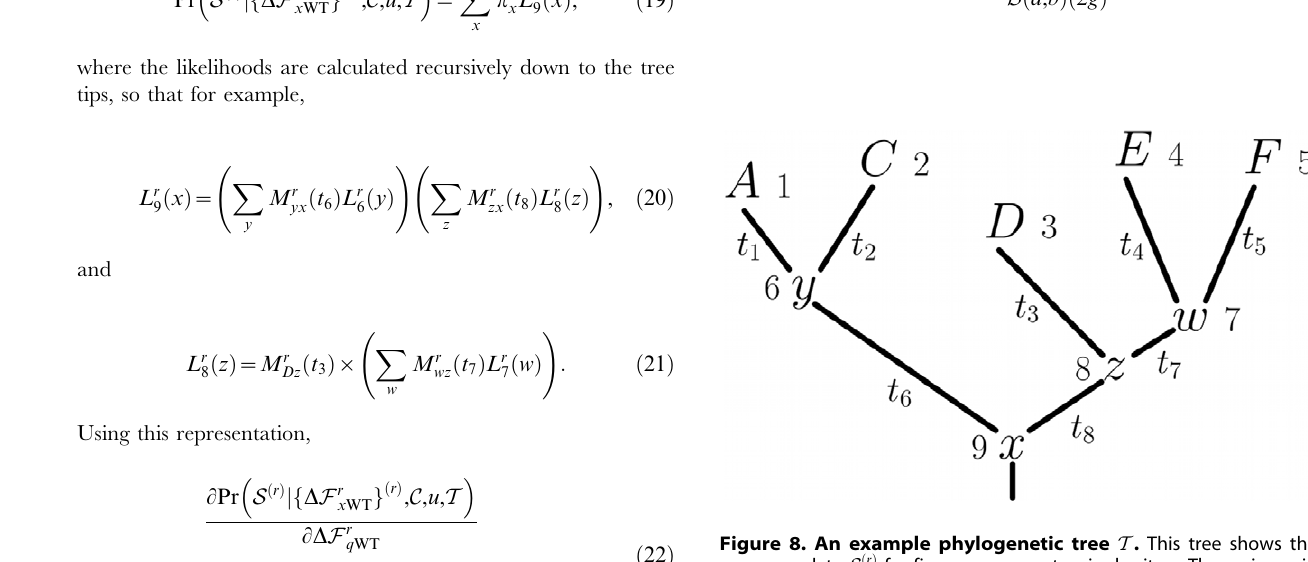
Figure 8. An example phylogenetic tree T . This tree shows the sequence data S r ð Þ for five sequences at a single site r . The amino acid codes at the tips of the branches ( A , C , D , E , and F ) show the residue identities for the five sequences at this site. The variables at the internal nodes ( x , y , z , w ) are the amino acid identities at the site for the ancestral sequences, and must be inferred. The numbers next to the nodes are unique identifiers for the nodes. The branch lengths ( t 1 , t 2 ,…) are proportional to the time since the divergence of the sequences.